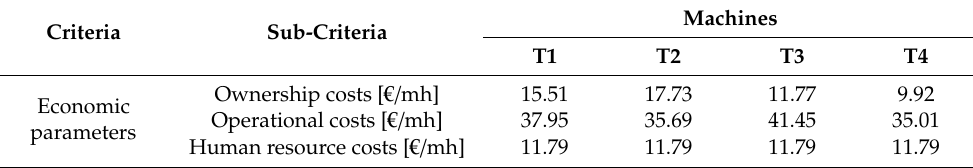
Table 7. Input parameters for applying the AHP method for economic parameters.